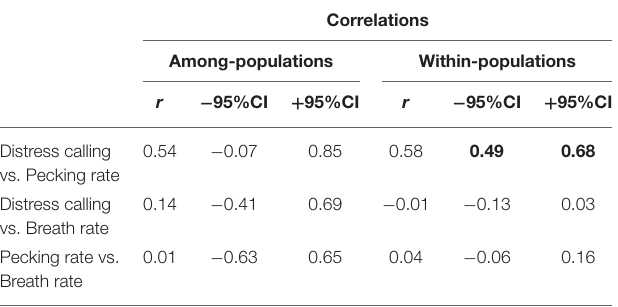
TABLE 2 | Within-individual and between-year repeatability of distress calling, pecking, and breath rates.